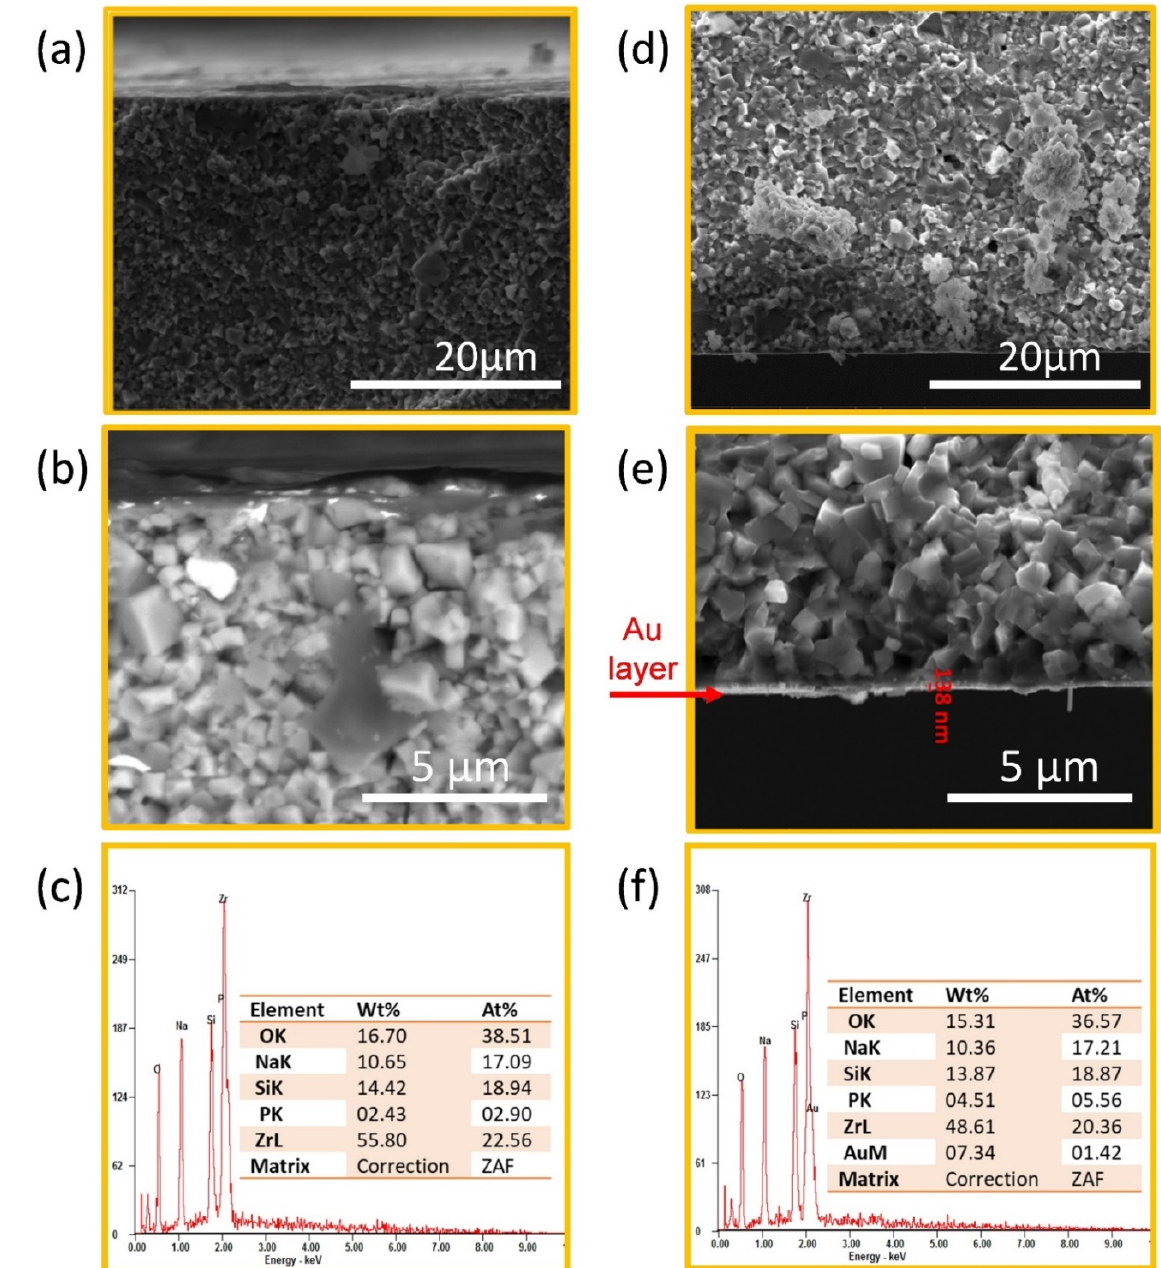
Figure 2. Cross-sectional SEM morphology and EDX patterns of ( a – c ) a Na 3 Zr 2 Si 2 PO 12 pellet sintered at 1230 °C. ( d – f ) Na 3 Zr 2 Si 2 PO 12 pellet showing the gold interlayer.